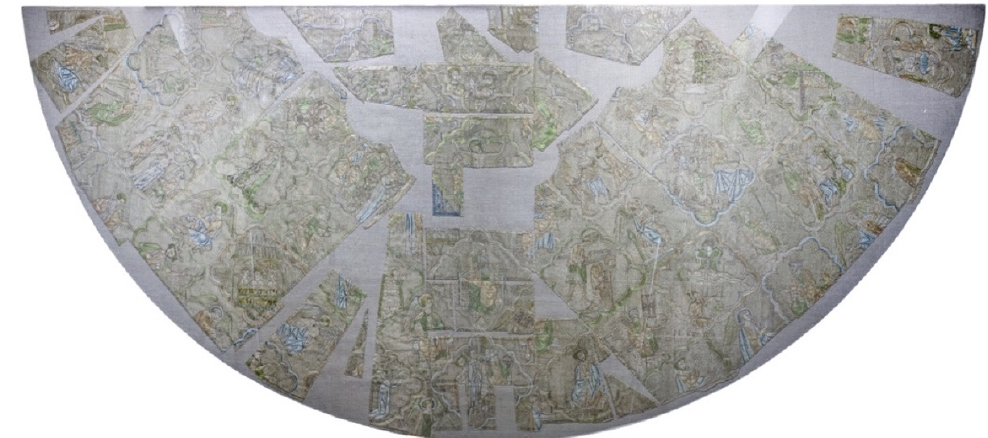
Figure 14. Anagni Cope, second half of the 13th century. Ancient treasury of Anagni Cathedral, now in the cathedral museum, Italy. © by concession of the Chapter of the Basilica Cathedral of Anagni. Photo: Graframan.com.